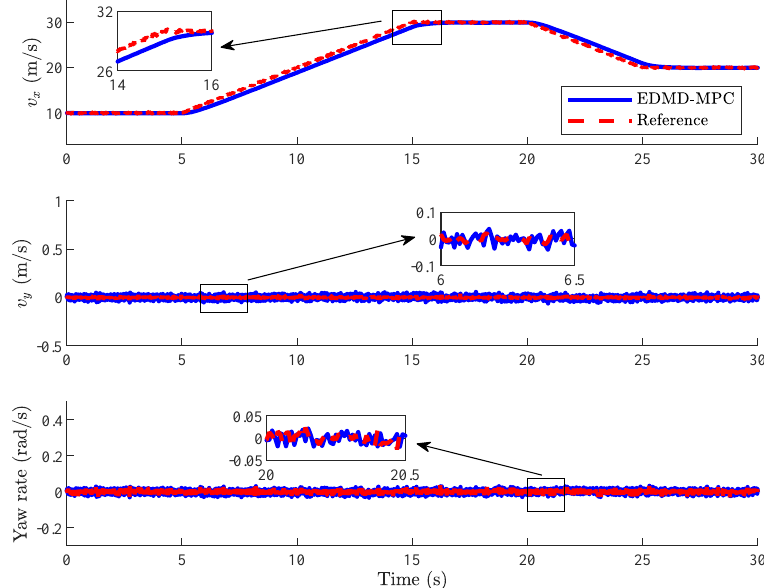
Figure 12. State evolution of EDMD-MPC (Case